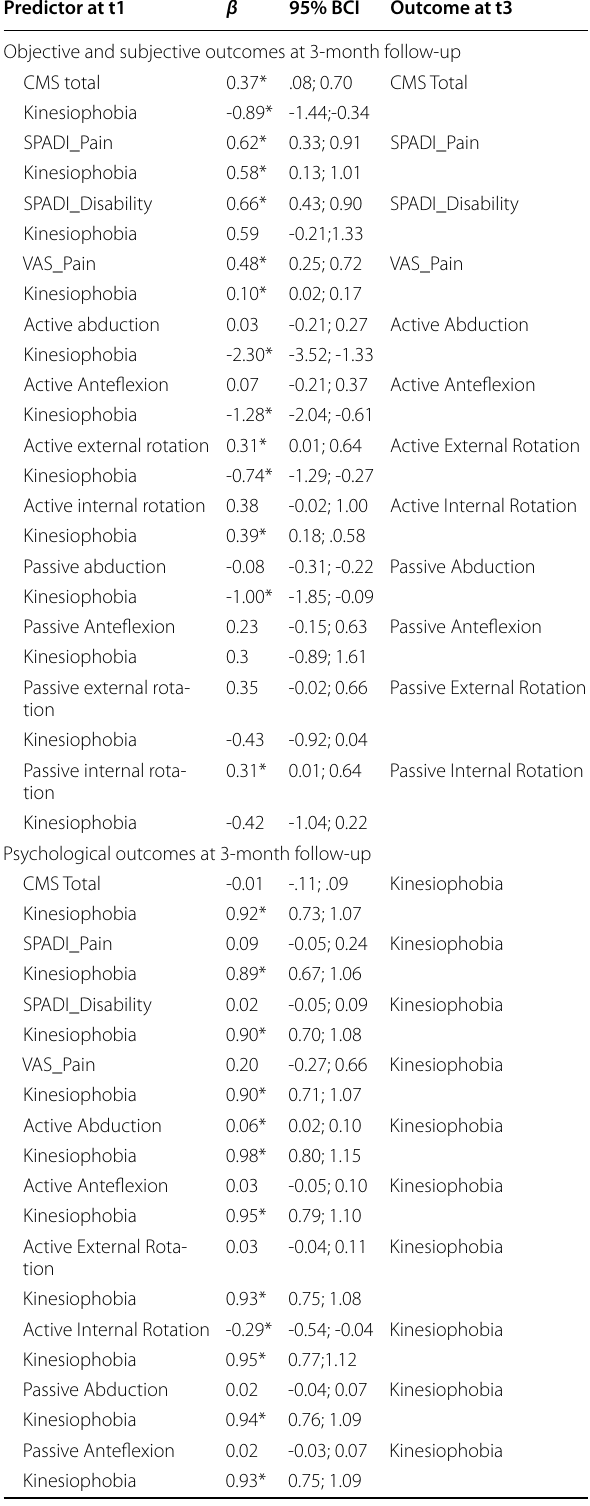
Table 2 The reciprocal effects between objective and subjective outcomes of hydrodilatation and kinesiophobia Predictor at t1 Objective and subjective outcomes at 3-month